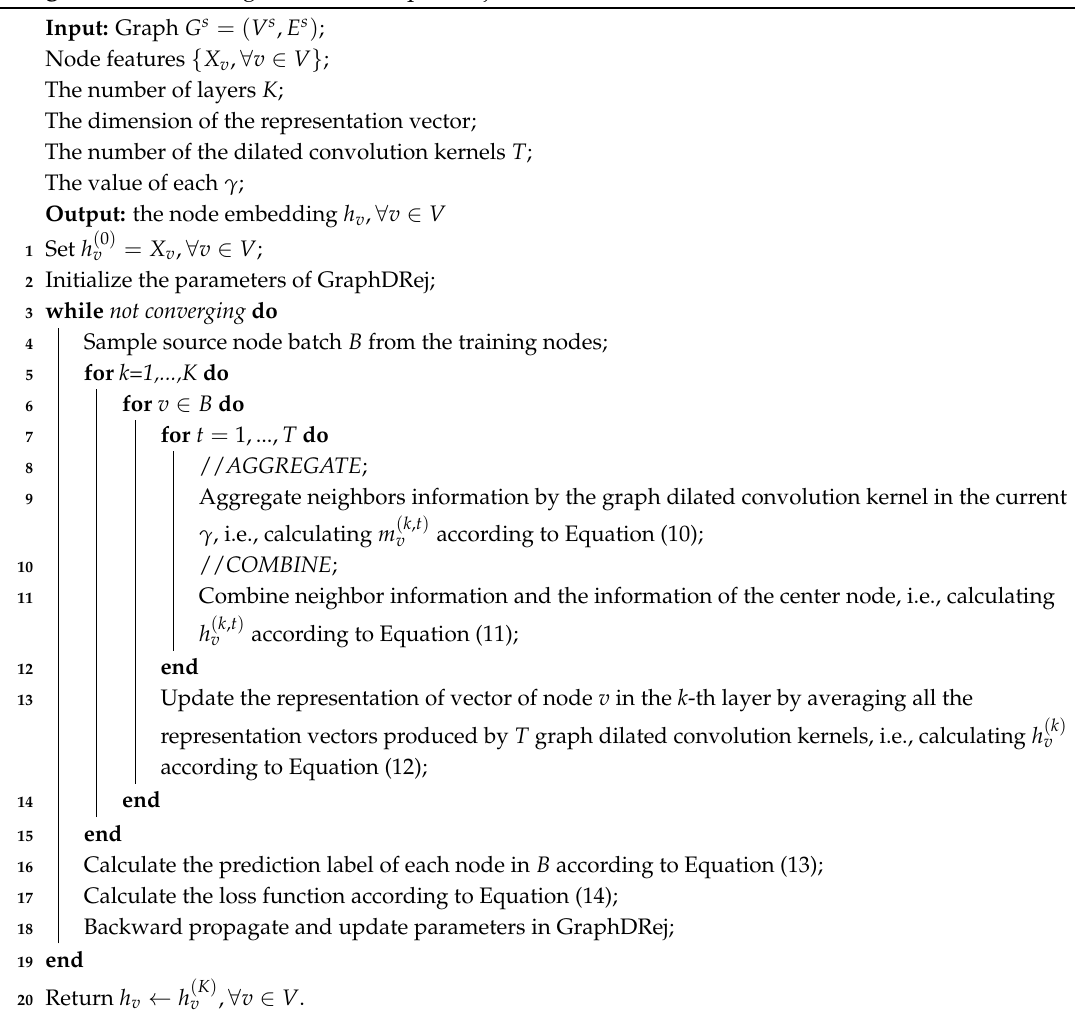
Algorithm 1: The Algorithm of